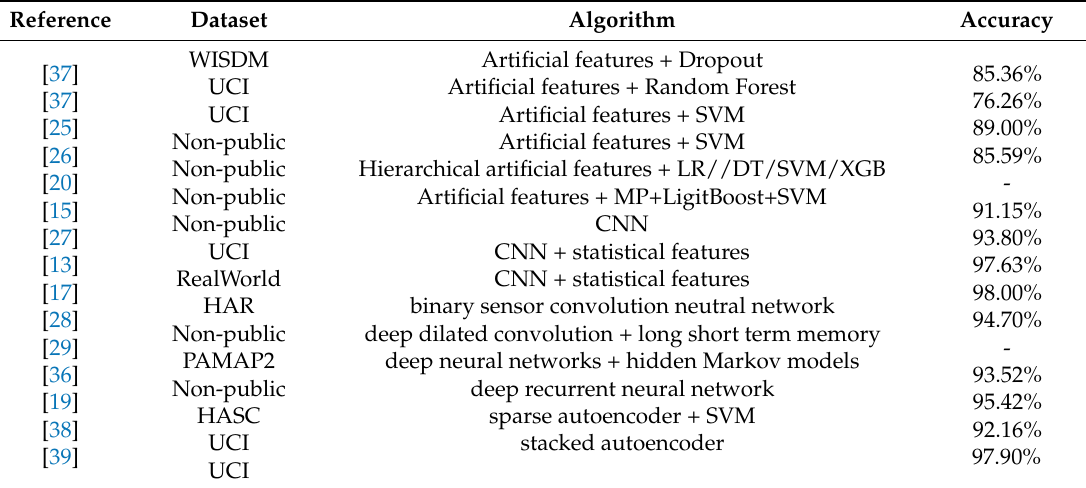
Table 1. The further experimental results of the related